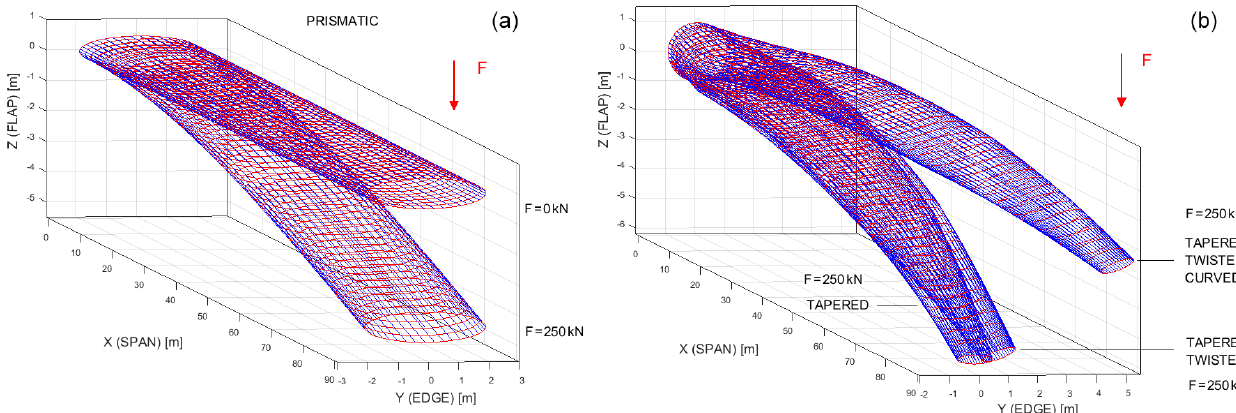
Figure 10. Prismatic case before and after deformation (a) and non-prismatic cases after deformation (b) .